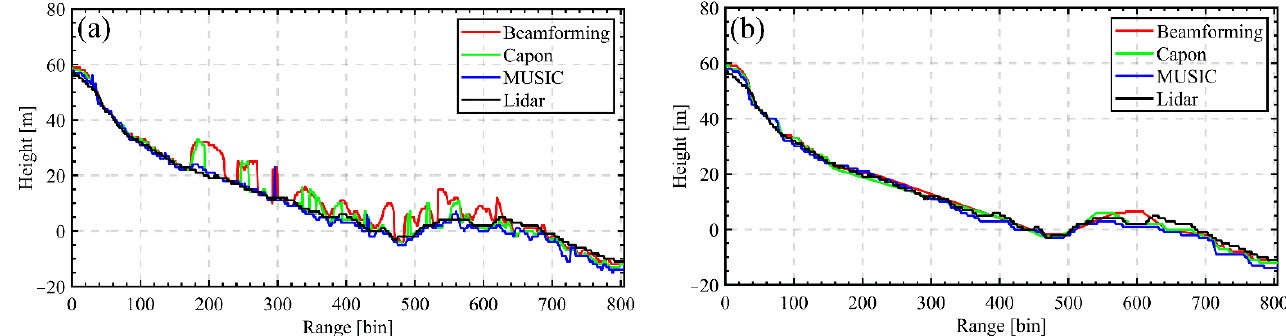
Figure 5. The underlying topography at the selected profile: ( a ) the results of the LM-based TomoSAR method; and ( b ) the results of the NLM-based TomoSAR method.